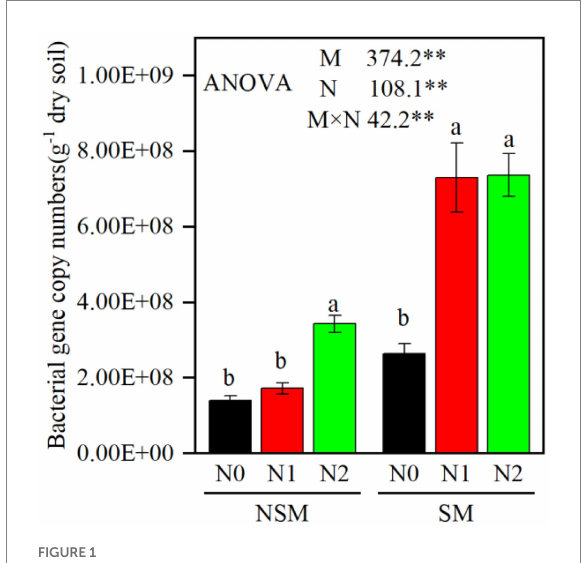
FIGURE 1 The abundance of bacteria gene copies in wheat rhizosphere soil under straw mulching and N fertilization treatments. M, mulching treatment; N, N fertilization treatment. M × N, the interaction of straw mulching and N fertilization NSM, no straw mulching; SM, straw mulching; N0, no N; N1, 120 kg N ha − 1 ; N2, 180 kg N ha − 1 . Data shown as mean ± S.D. ** statistically significant difference ( p < 0.01). Different letters above columns indicate statistically significant difference ( p < 0.05) between N fertilizer levels within NSM and SM.